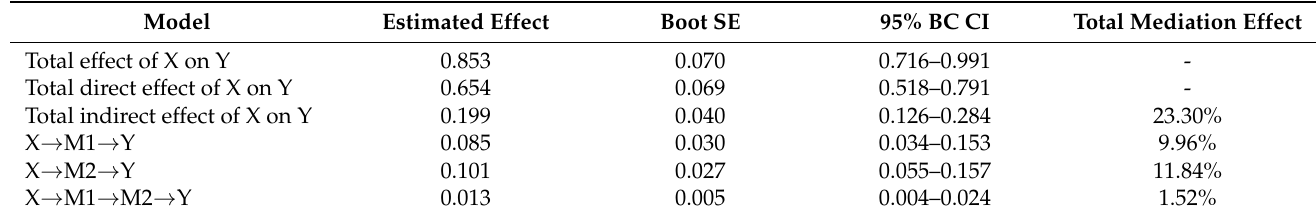
Table 4. Total, direct and indirect effects in the multiple mediator model.